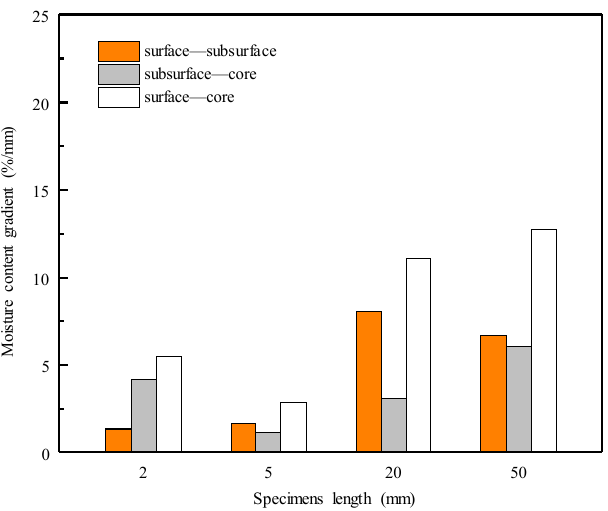
Figure 6. Moisture content gradients in the cross sections of specimens with lengths of 2, 5, 20, and 50 mm after the 12th dewatering cycles.